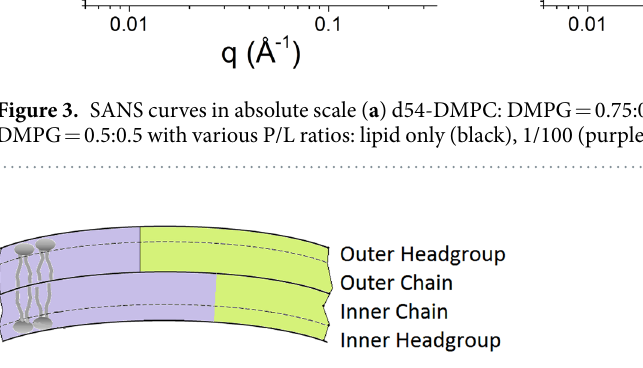
Figure 4. Four-layer lipid bilayer model used in the data fitting. Bilayer is divided into inner and outer leaflets with chain and headgroup regions. Blue and green represents different lipid compositions that are distributed unevenly in different